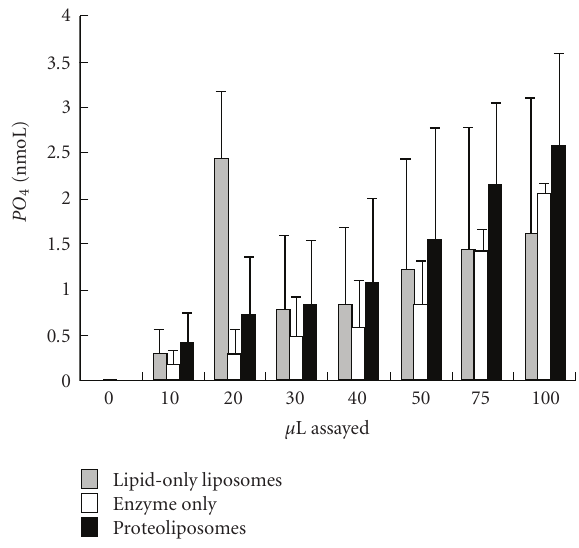
Figure 3: Mean phosphate (PO 4 ) detected (nmoL ± SE) in liposomes (lipid-only liposomes), Na + K + -ATPase alone (enzyme- only), and proteoliposomes (liposomes containing ATPase) made by filtration ( n = 3). Measurements were taken at 0, 10, 20, 30, 40, 50, 75, and 100 μ l. Liposomes and proteoliposomes contained 0.5 μ g lipid/ μ l prior to vesicle production, while proteoliposomes and enzyme-only contained 0.025 μ g Na + K + -ATPase/ μ l. The PO 4 in each well was detected by reading colour intensity at 750nm. The slope across concentrations was linear with increasing concentra- tion for enzyme-only and proteoliposomes ( P < .